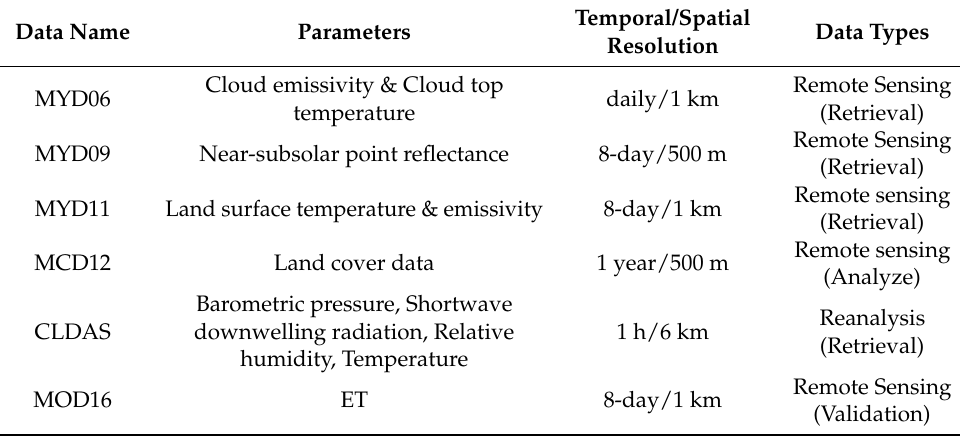
Table 1. Experimental data used in this study, their resolution and